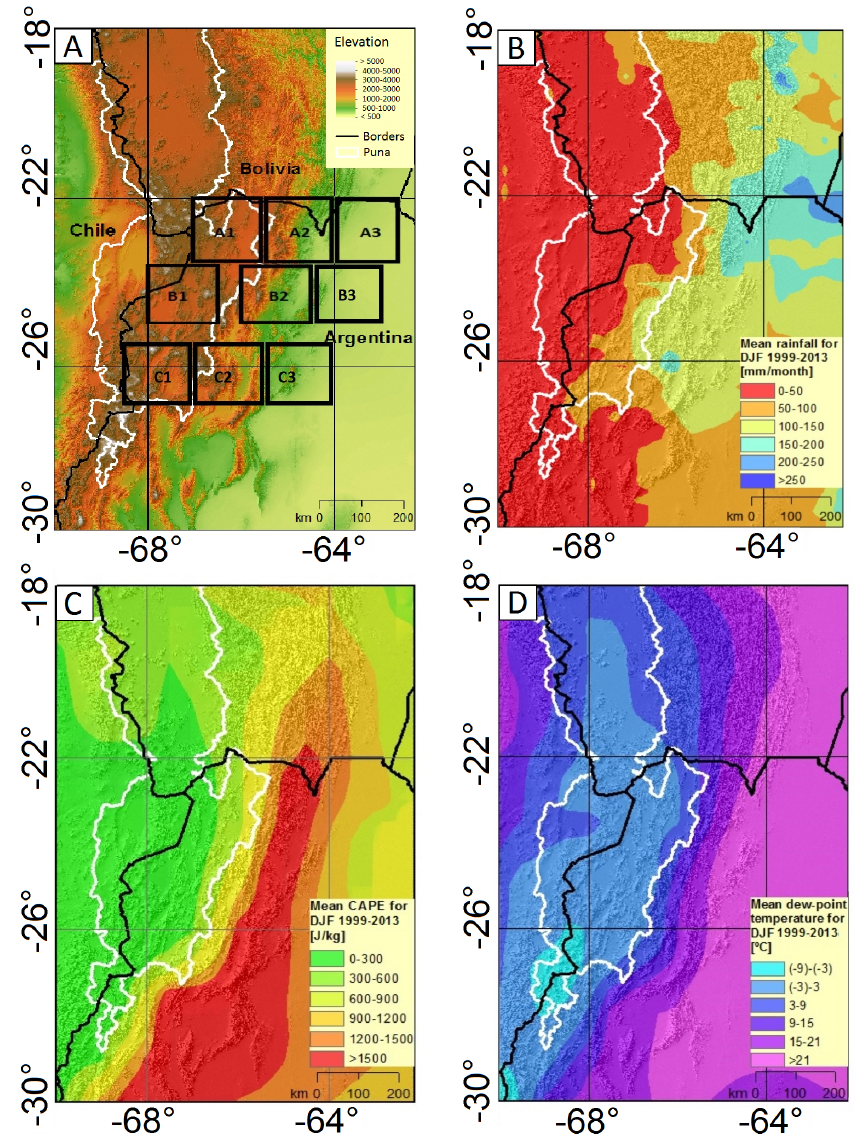
Figure 4. ( A ) Topographic and climatic overviews of the study region in NW Argentina. White line outlines the central Andean Plateau, black lines are international borders. Boxes A1, B1, and C1 are in the high-elevation Puna Plateau (southern central Andean Plateau), boxes A2, B2, C2 are located in the intermediate elevation zone characterized by intramontane basins and high relief, and boxes A3, B3, C3 lie in the low-elevation foreland area. ( B ) Seasonal mean rainfall (DJF) derived from TRMM 3B42 (1999–2013) shows the E–W rainfall gradient with wet, low elevation foreland regions and the dry, high-elevation central Andean Plateau. ( C ) Seasonal mean CAPE based on ERA-interim reanalysis data shows the E–W atmospheric stability gradient. ( D ) Seasonal mean dew-point temperature based on ERA-interim reanalysis data shows the E-W atmospheric moisture availability